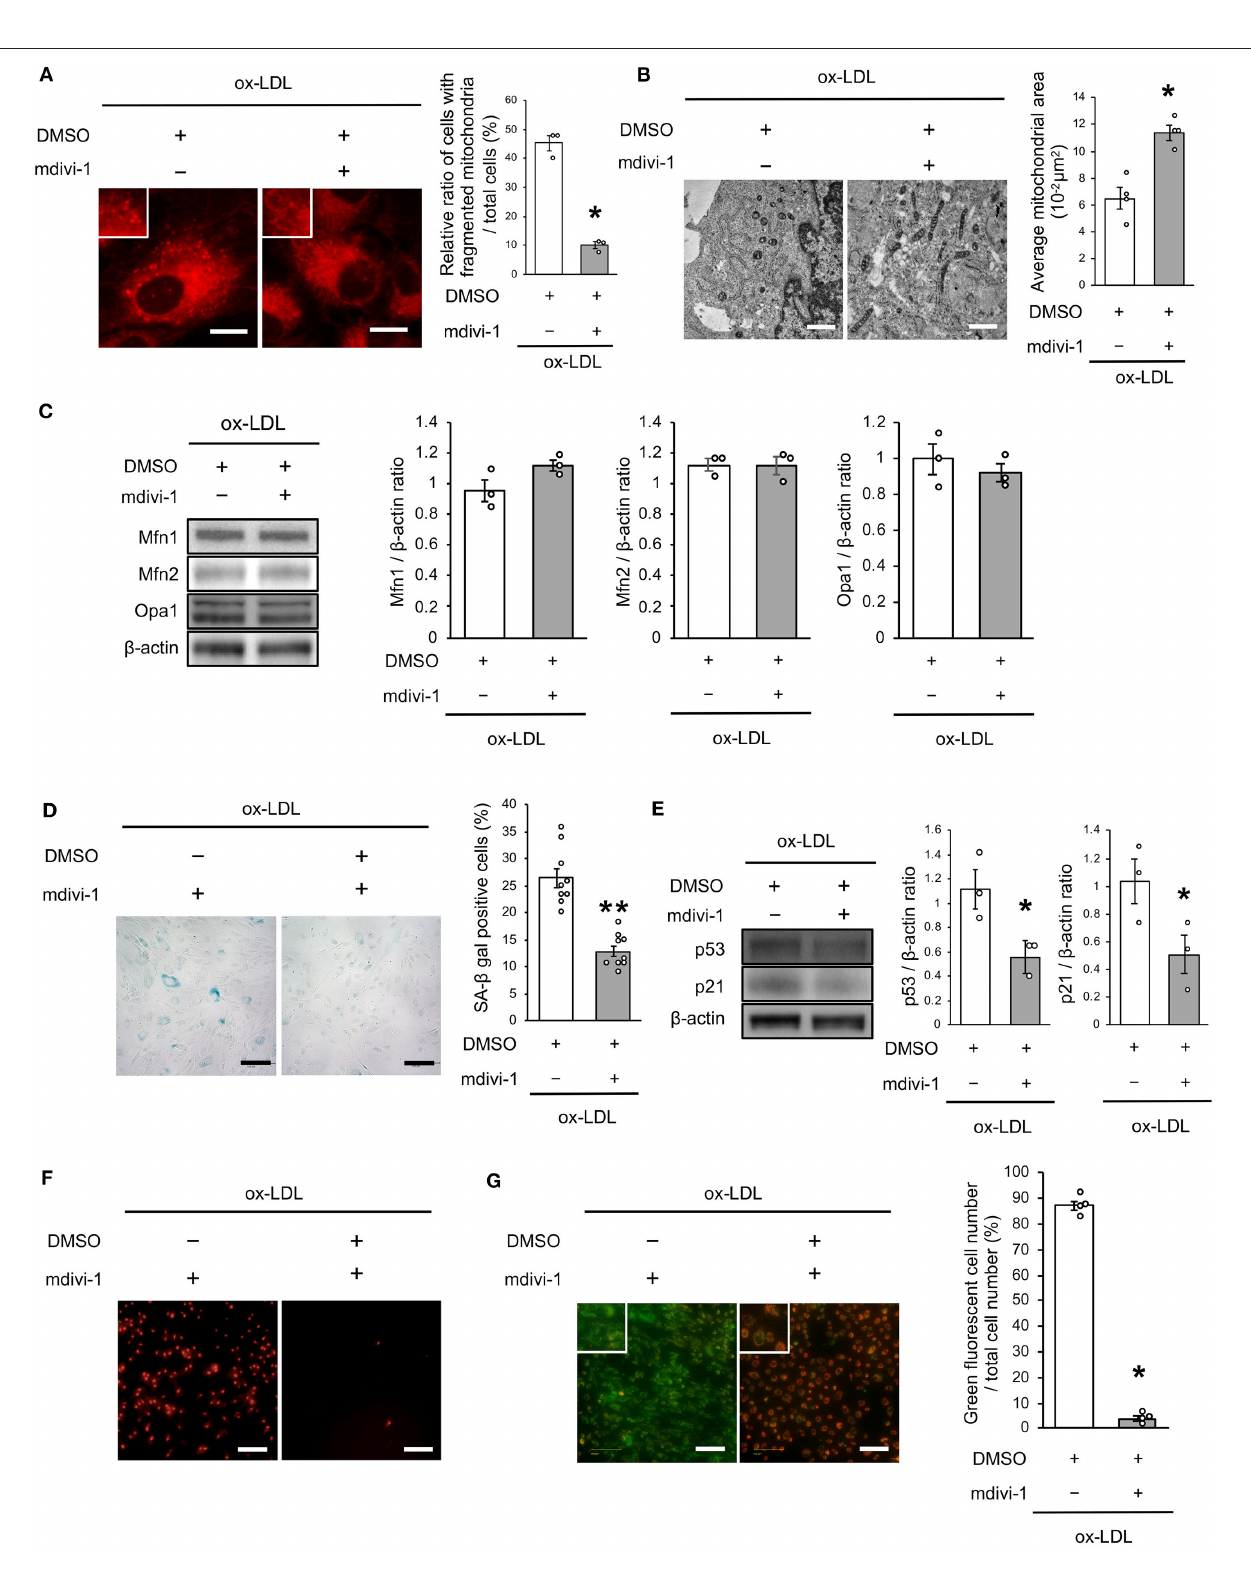
FIGURE 2 | Mdivi-1 treatment retarded excessive mitochondrial fission, ROS production, mitochondrial dysfunction and cellular senescence, which were induced by ox-LDL. (A) Representative images and quantitative analysis of Mito-tracker Red in ox-LDL-treated cells with mdivi-1 or the control vehicle. Scale bar = 10 µ